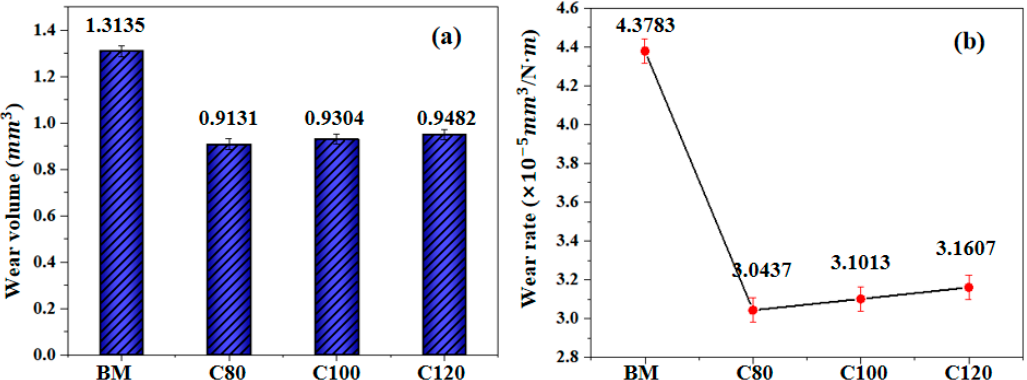
Figure 12. Wear Results of the Nickel-Base Alloy at Different Scanning Speeds after EBSA: ( a ) Wear Volume; ( b ) Wear Rate.